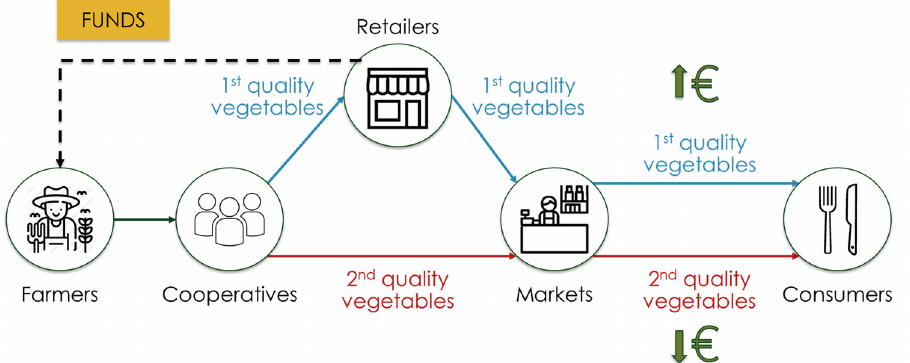
Figure 1. Agri-food supply chain under